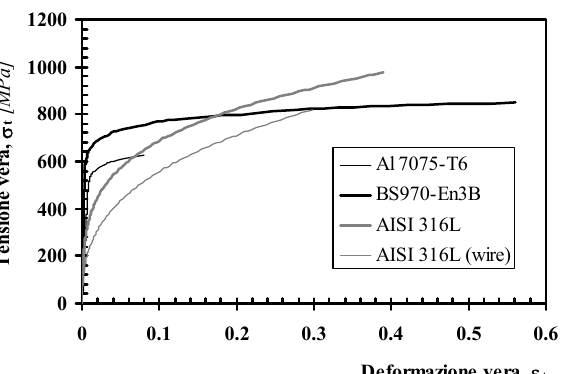
Figura 6: Leggi costitutive dei materiali investigati espresse in termini di tensioni e deformazioni vere e tracciate in accordo alla relazione di Ramberg-Osgood. Figure 6: True stress vs. true strain curves of the investigated materials.